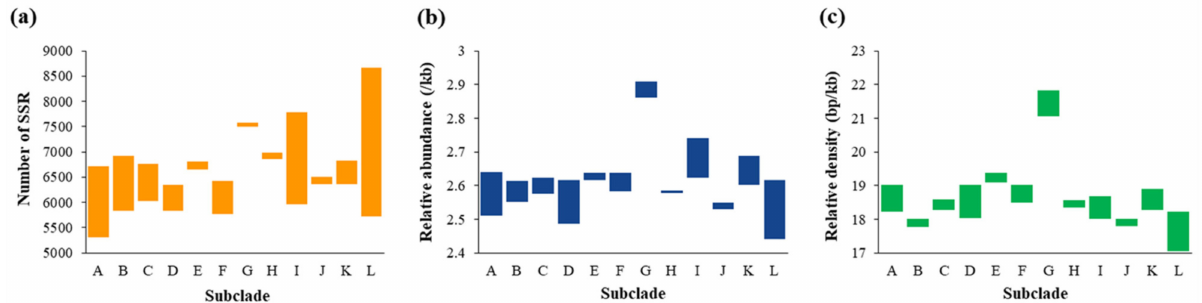
Figure 2. Number ( a ), relative abundance ( b ), and relative density ( c ) of SSRs in genomes of 54 Parasynechococcus -like strains. Data were presented by the subclades (A–L) identified in Figure 1b. Meanwhile, the results indicated that a total of 11,112 cSSRs (an individual SSR being a component of a CSSR) were identified in the genomes of 54 Parasynechococcus